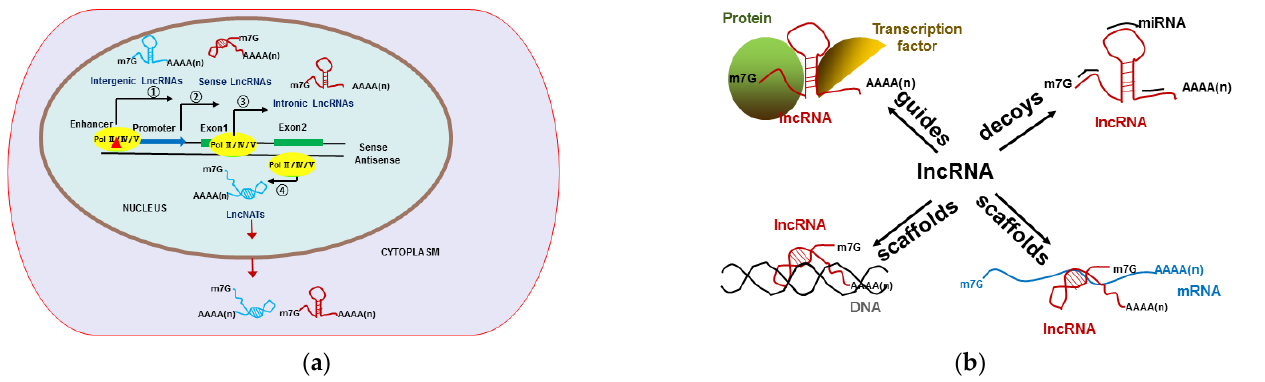
Figure 2. Transcription of lncRNA and its regulatory role in plant cell. ( a ) Plant lncRNAs are transcribed by RNA poly- merases Pol Ⅱ , Pol Ⅳ , and Pol Ⅴ from ① enhancers, ② promoters, ③ introns of genes, or ④ antisense of genes. ( b ) The lncRNAs act as scaffolds, guides, and decoys to regulate gene expression through interacting with DNA, RNA, protein and